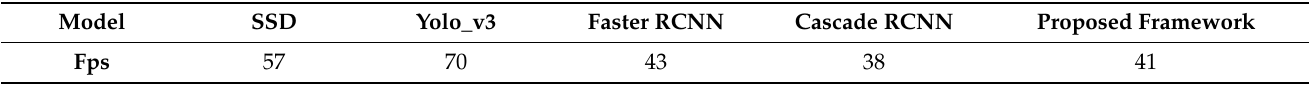
Table 6. Detection frame rate of different